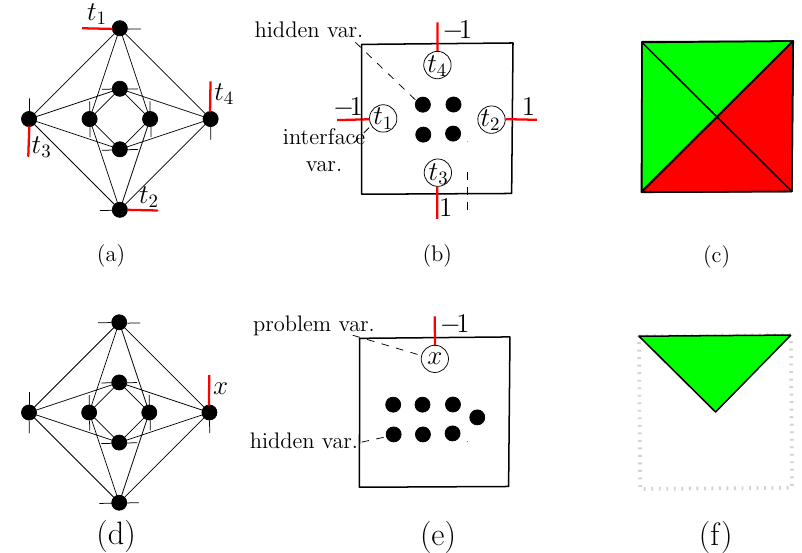
Figure 2. Illustration of the internal ( ) and problem ( ) type gadgets and tiles. ( a ) A cell of the Chimera graph. Short lines denote couplers connecting the cell to other cells. ( b ) The logical structure of the corresponding internal gadget, showing the types of the variables, and, as an example, a concrete assignment of values to the interface variables. ( c ) The corresponding tile as used in our embedding illustrations, with red color for +1 and green for − 1 type variables. Analogous illustrations for the problem type gadget and tile are found in ( d – f